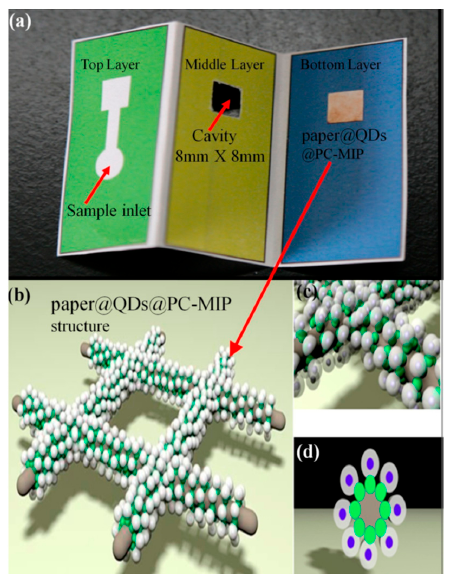
Figure 10. The structure of the origami paper-based microfluidic system. Republished with permission from Li et al.